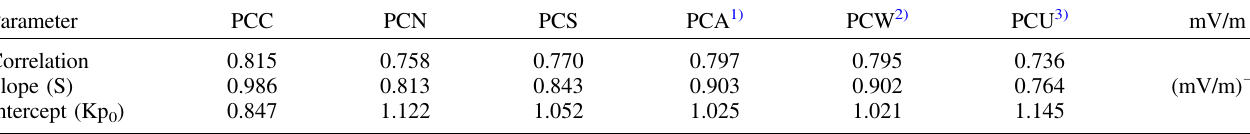
Table 1. Correlation coef fi cients and regression results for Kp-PC relations. Epoch 1998 – 2018.